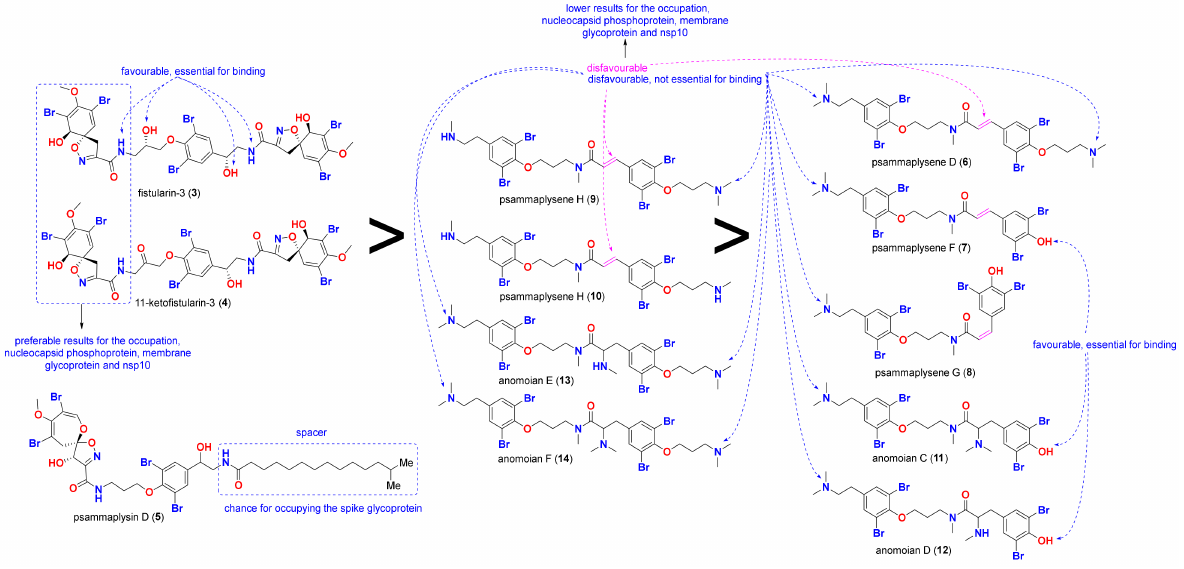
Figure 9. SARs of the studied